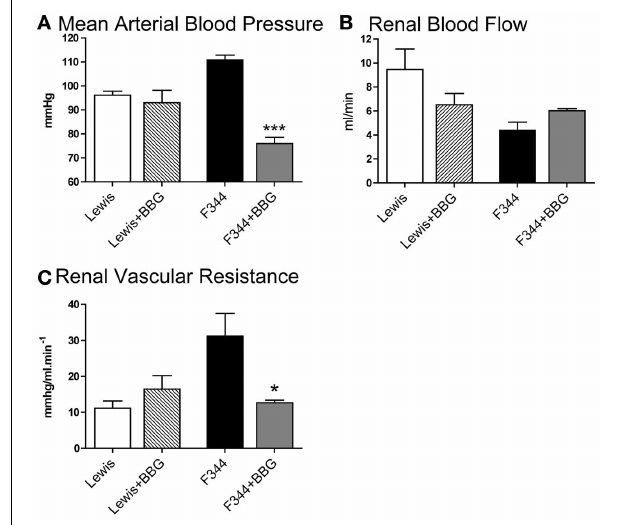
FIGURE 5 | (A) Mean arterial blood pressure; (B) left renal artery blood flow and (C) renalvascularresistanceintheleftrenalarterymeasuredinLewisand F344 rats receiving either saline or Brilliant Blue G by intravenous infusion. Data are mean ± SE . Statistical comparisons were made within strain by unpaired t -test. ∗∗∗ P < 0 . 001; ∗ P < 0 . 05. Statistical comparisons were made using one way ANOVA with Bonferroni post-test.